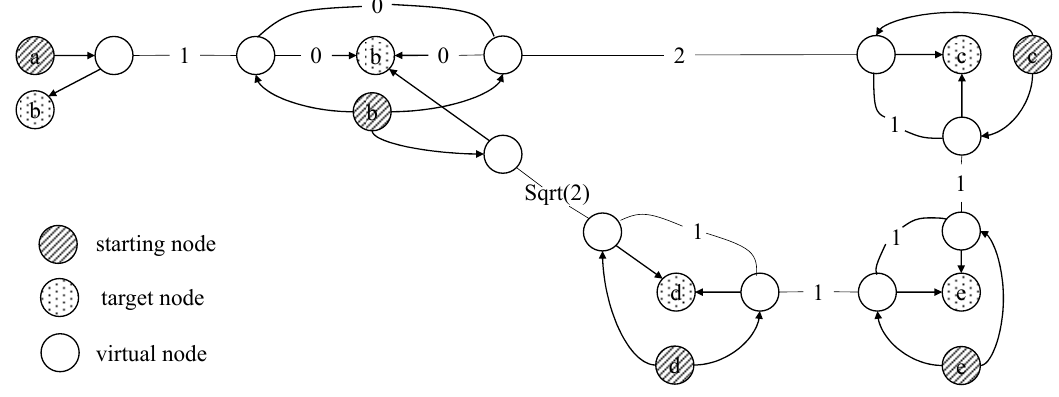
Figure 6. New graph with distance and turn information.